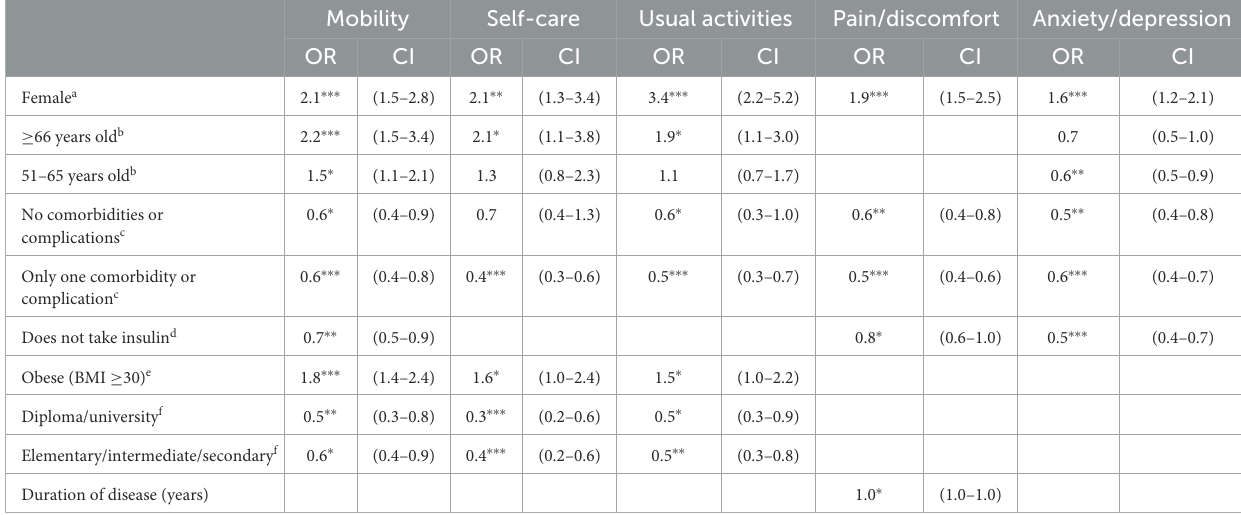
TABLE 6 EQ-5D-5L sub scales regression